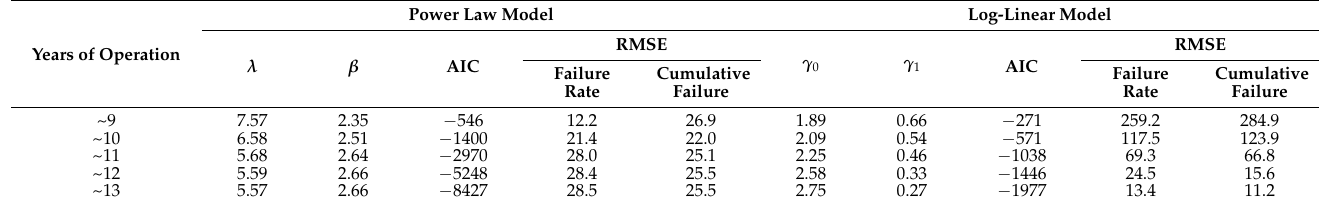
Figure 3. Predicted cumulative fiber failure by power law model (red) and log-linear model (blue). ( a ) predicted using data up to the 9th year; ( b ) 10th year; ( c ) 11th year; ( d ) 12th year; and ( e ) 13th year of operation. The shaded area shows the 95% confidence interval for each model. Dotted lines show cumulative failures for the reduced filtration performance level 𝑊(𝑡) 𝑊(0)⁄ of 70%, 60%, and 50%. Table 3. Estimated parameters for power law model and log-linear model intensity functions.